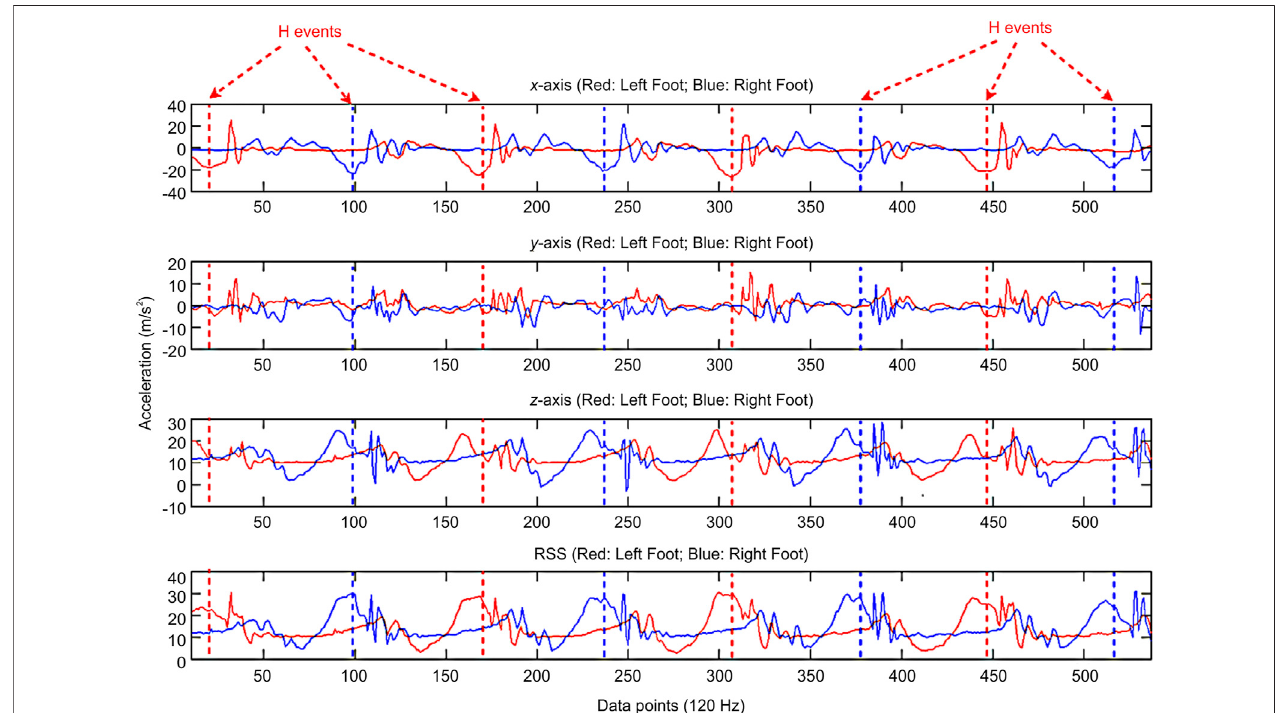
FIGURE 4 | Gait signal data after fi ltering and segmentation. H, heel strike; RSS, root sum of